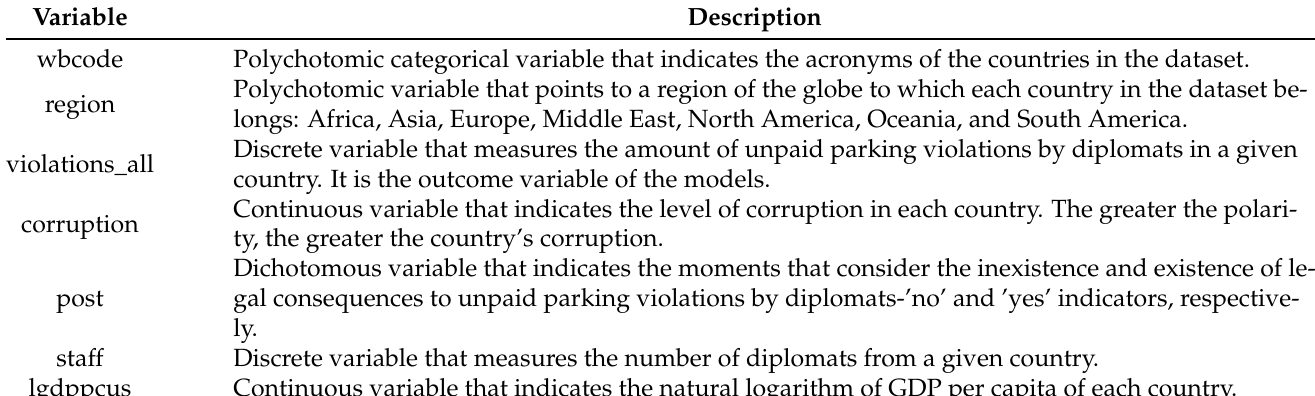
Table 4. Description of the variables considered in the Fisman and Miguel’s Model